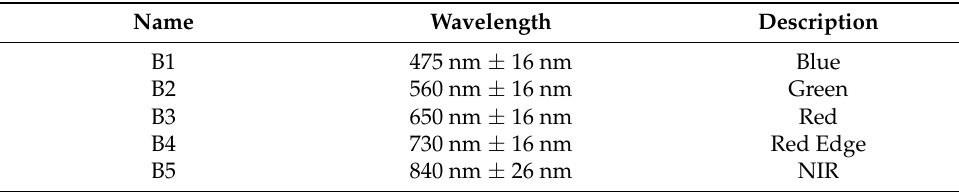
Table 4. The list of the vegetation indices used in this work.